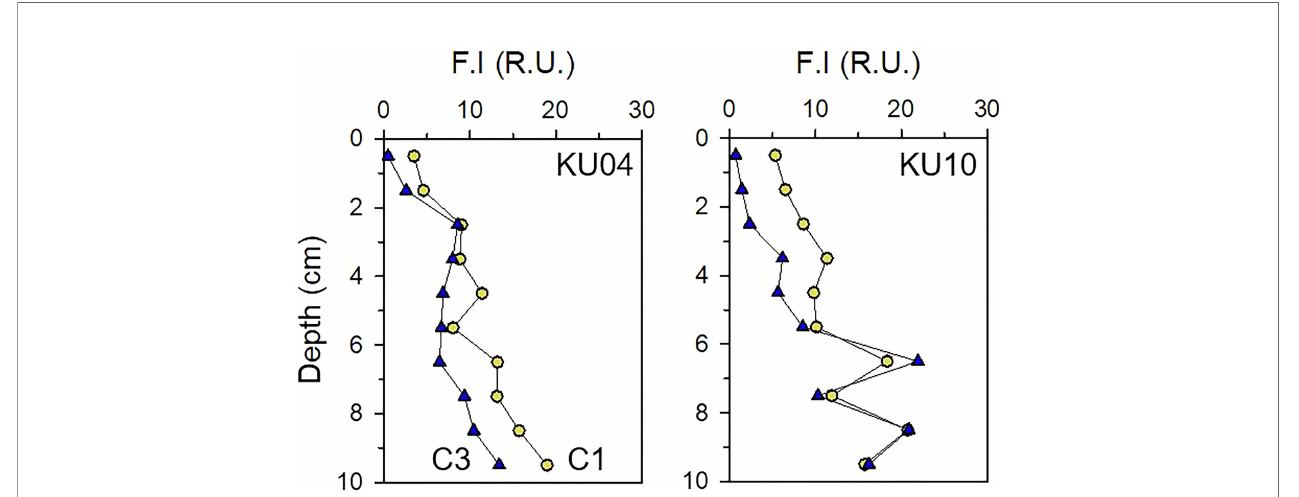
FIGURE 4 | Vertical pro fi les of fl uorescence intensity of FDOM H (C1 and C3 components) in pore water at the slope site (KU04) and basin site